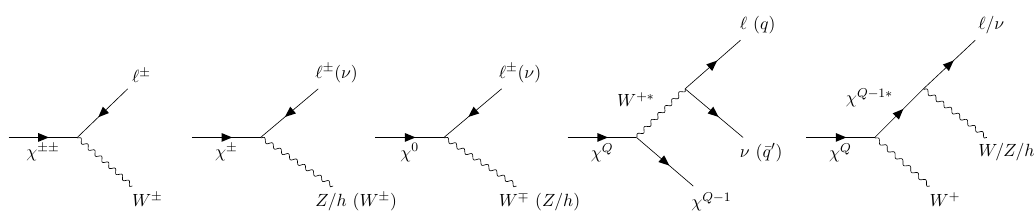
Figure 3 . Representative Feynman diagrams for the decays of the exotic fermions: Category-I (first, second and third), Category-II (fourth) and Category-III (fifth)